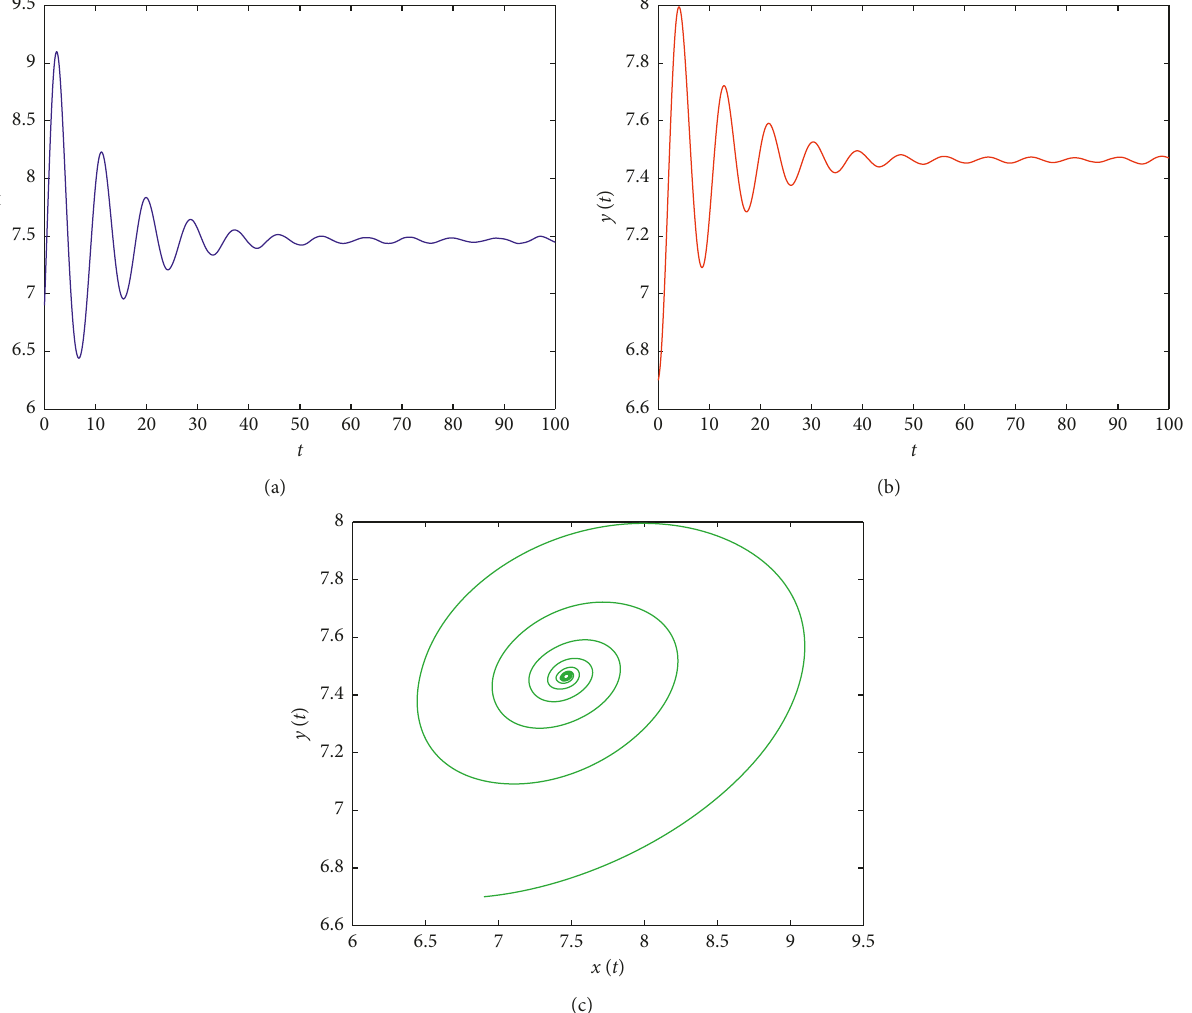
Figure 9: The time series and portrait phase of model (71) when u < Kr /4; here α � 0 . 3 ,K � 8 , r � 2 , and u � 1. (a) The time series of x ( t ) ; (b) the time series of y ( t ) ; (c) the portrait